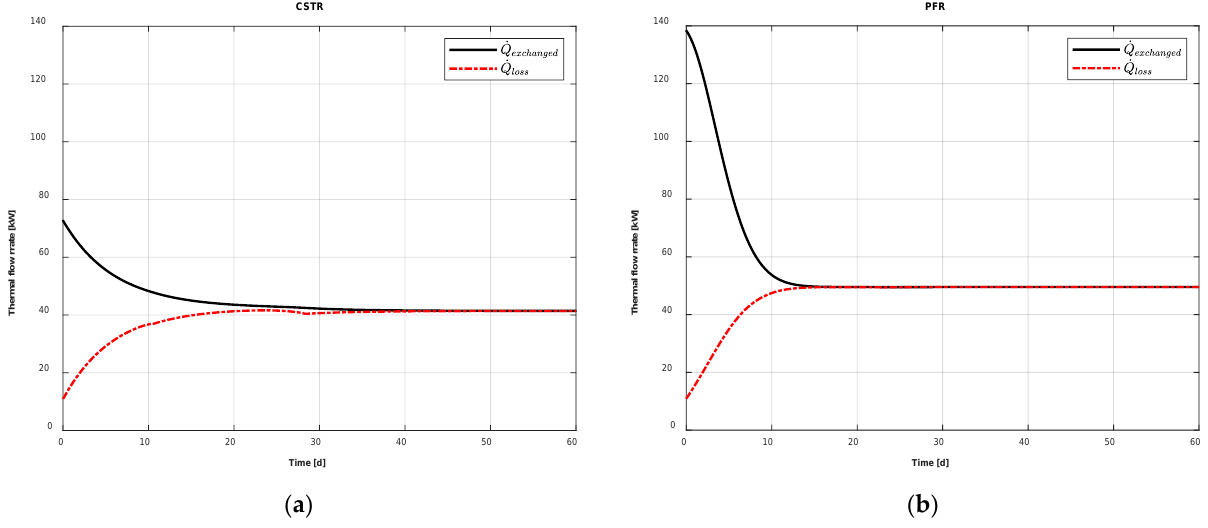
Figure 8. Exchanged and loss thermal flow rate in CSTR ( a ) and in PFR ( b ). The exchanged thermal flow rate, Q exchanged , represents the total input energy. This term represents the thermal energy supplied to the digester by means of the heat exchanger installed into the digester. The thermal losses, Q loss , are due to the heat loss toward the environment and the thermal flow rate related to the outgoing biogas and digestate. Figure 8 proves that the PFR model is featured by a lower thermal inertia with respect to the CSTR one. In fact, the heat exchanger supplies a higher amount of heat to the waste into the digester in the PFR model with respect to the CSTR case. In addition, PFR achieves the steady state earlier, i.e., 12 days (PFR) vs. 22 days (CSTR). Figure 9 compares the temperatures of the CSTR and PFR.